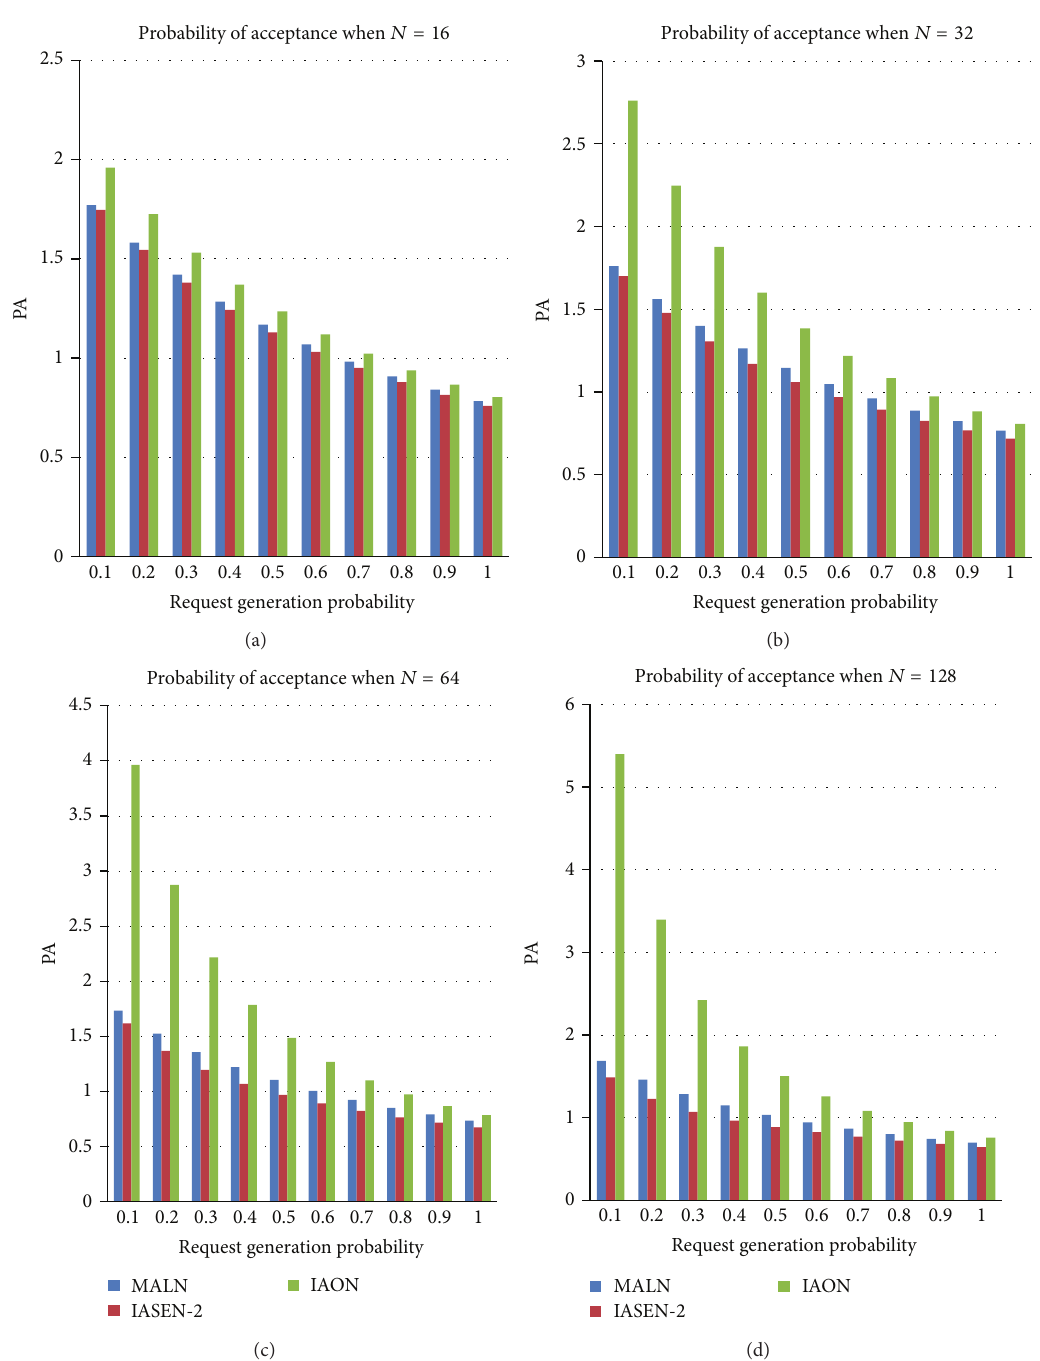
Figure 10: The probability of acceptance of MALN, IASEN-2, and IAON when network sizes are 16, 32, 64, and 128 separately.